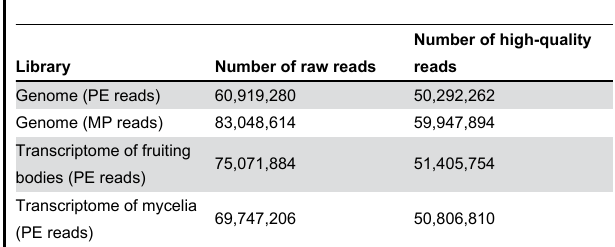
Table 1. The numbers of sequencing reads.